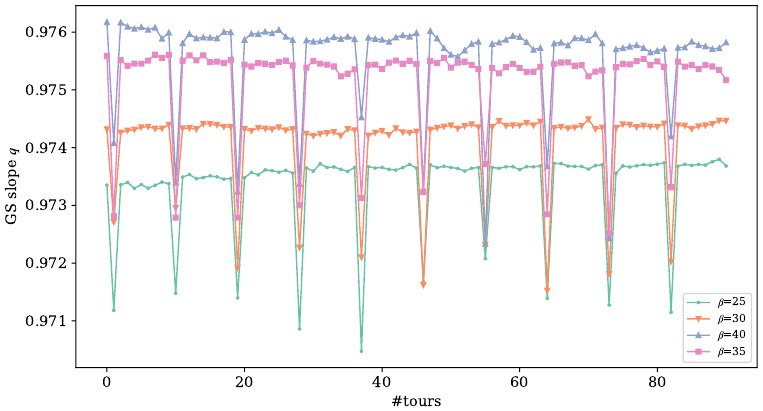
Figure 2. The evolution of GS slope q during reprocessing, n = 120, k = 8, β = 25,30,35,40. Root Hermite Factor.